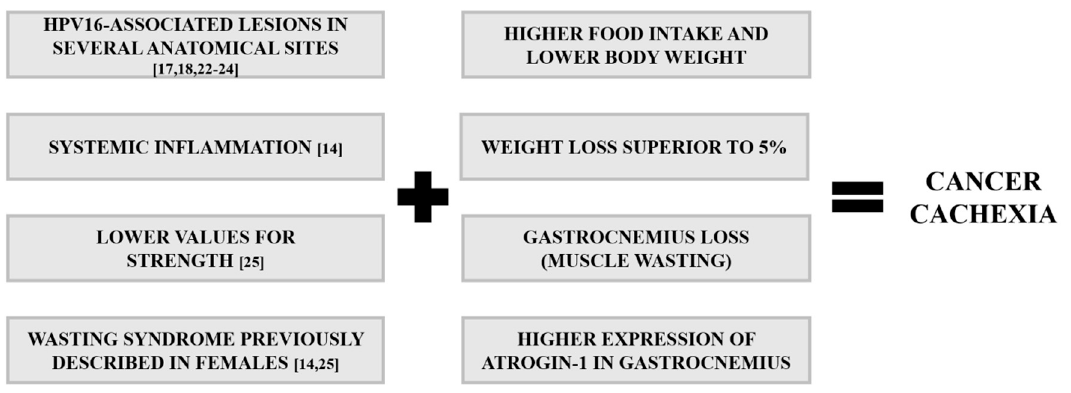
Figure 10. Key features of cancer cachexia in K14-HPV16 mice. Lesions associated with HPV16, ranging from hyperplasia to carcinoma, occur in typical anatomical sites. Systemic inflammation, low values of muscle strength and muscle wasting occur in K14-HPV16 transgenic mice. These events help to validate this model for studying cancer